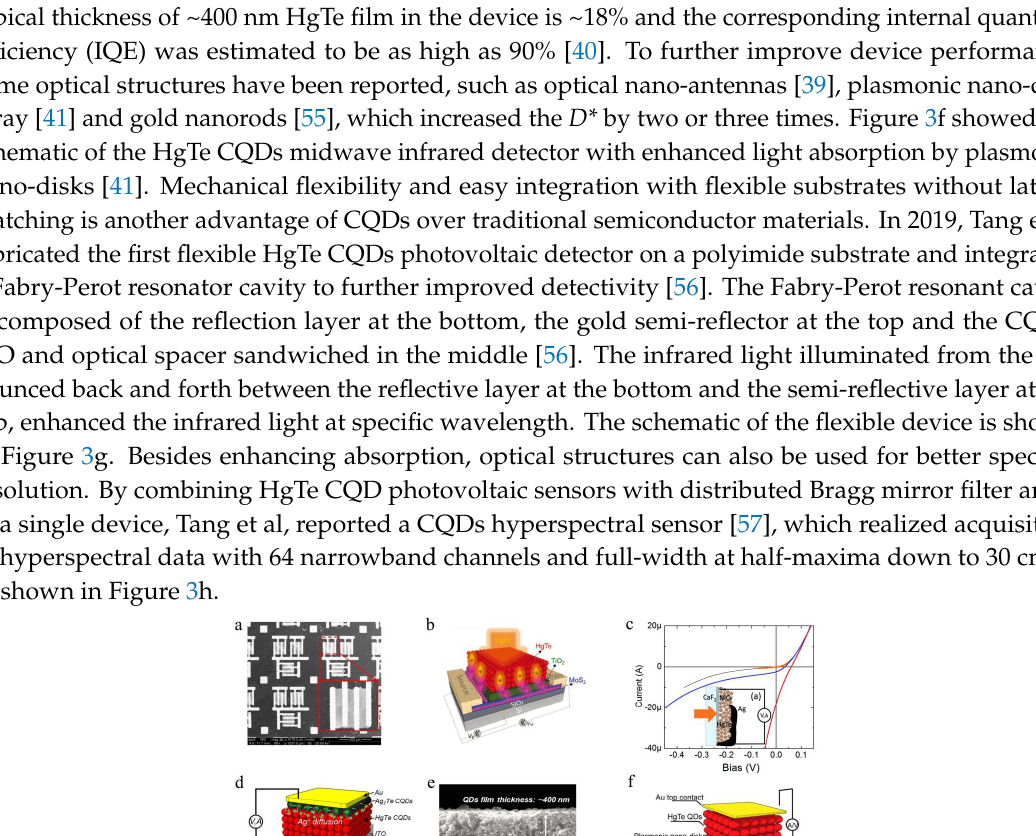
Table 1. Performance comparison between HgTe CQDs photodetectors.